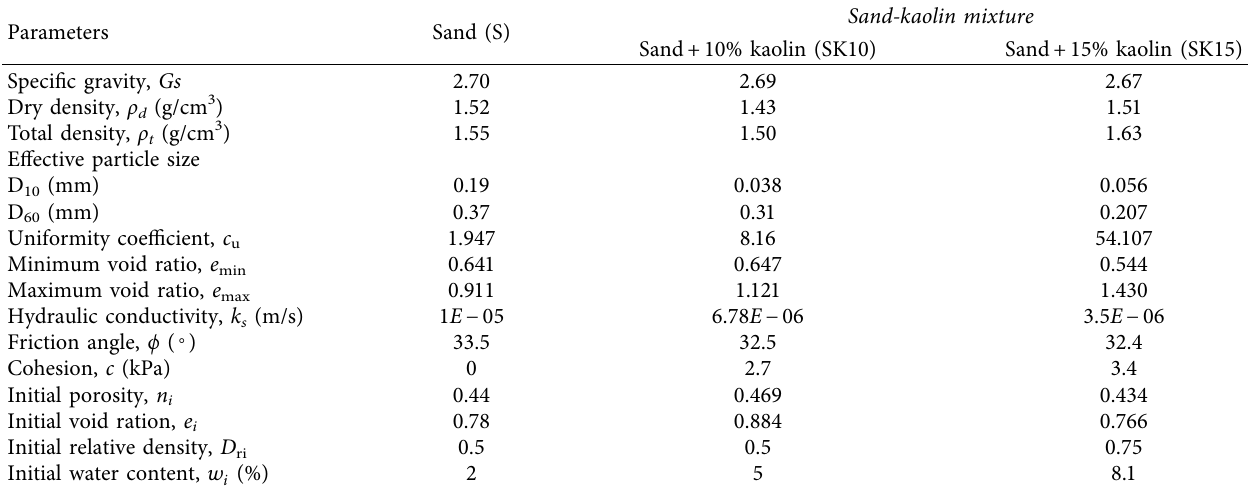
Figure 2: (a) Mohr–Coulomb failure envelopes and (b) grain size distribution curves of S (blue), SK10 (orange), and SK15 (green). Table 1: Basic physical and mechanical properties of the S and sand-kaolin mixture SK10 and SK15 built in the small-scale model and the initial conditions at the start of a test